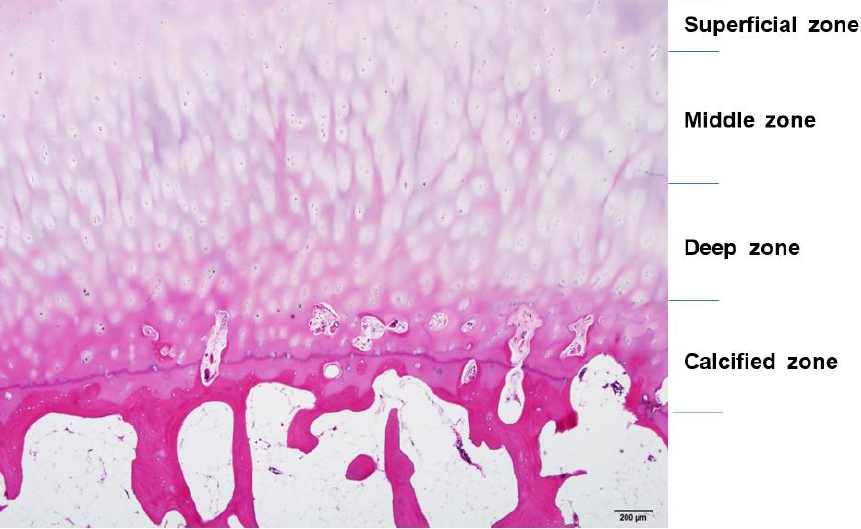
Figure 3. The structure of articular cartilage, comprised of four zones: superficial, middle, deep, and calcified. Among zones, there are differences in collagen fibers, arrangement of chondrocytes, and distribution of proteoglycans and glycosaminoglycans (GAGs). Hematoxylin and eosin staining. Scale bar, 200 μm.